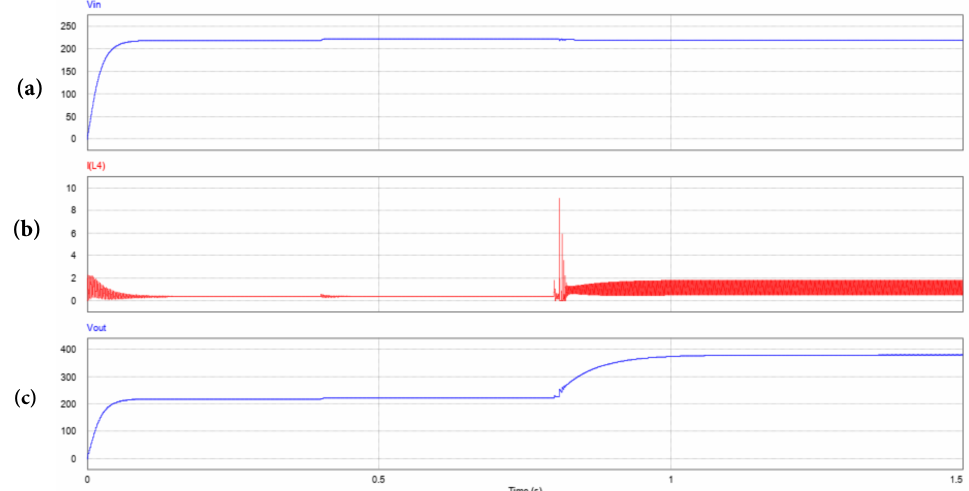
Figure 34. Start-up sequence with one 380 V output boost convertert, ( a ) input capacitor voltage, ( b ) inductor current ( c ) boost converter voltage output.